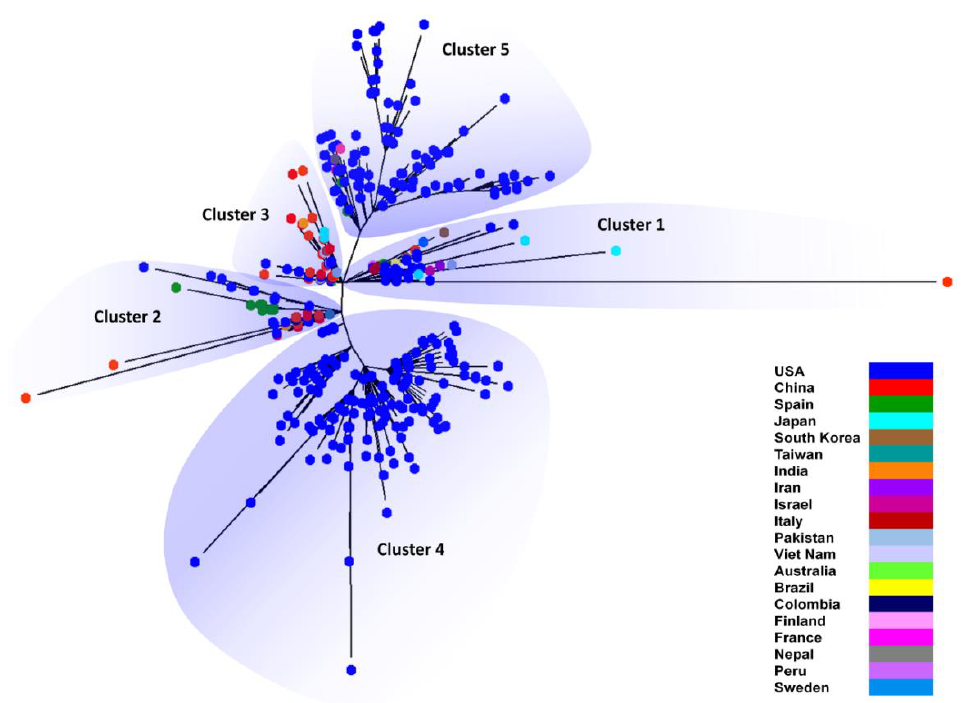
Figure 5. Unrouted phylogram showing the clusters of SARS-CoV-2 isolates across 20 different countries/territories. Cluster 1 represents the root cluster formed with the isolate from the Wuhan outbreak, China.